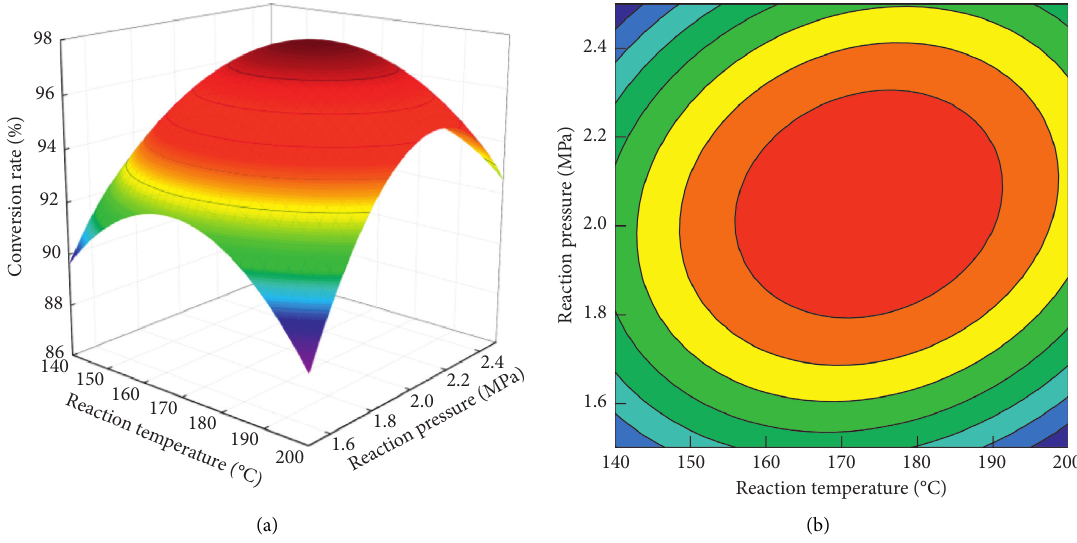
Figure 13: Effect of reaction temperature and pressure on conversion.